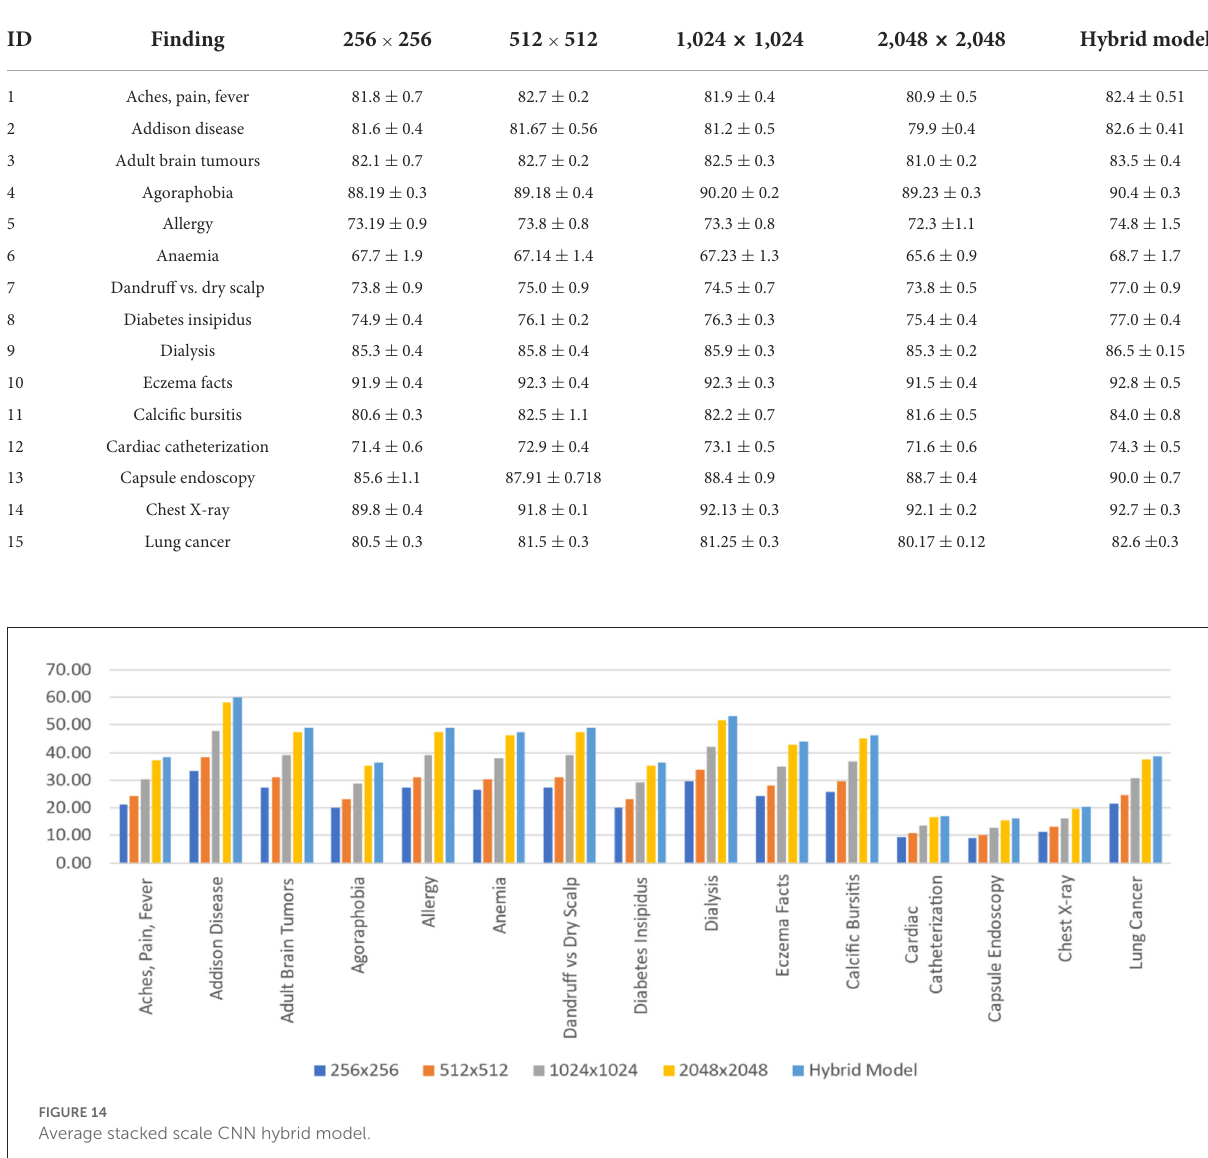
TABLE 7 AUCs for 15 TRAINED MedIMG.